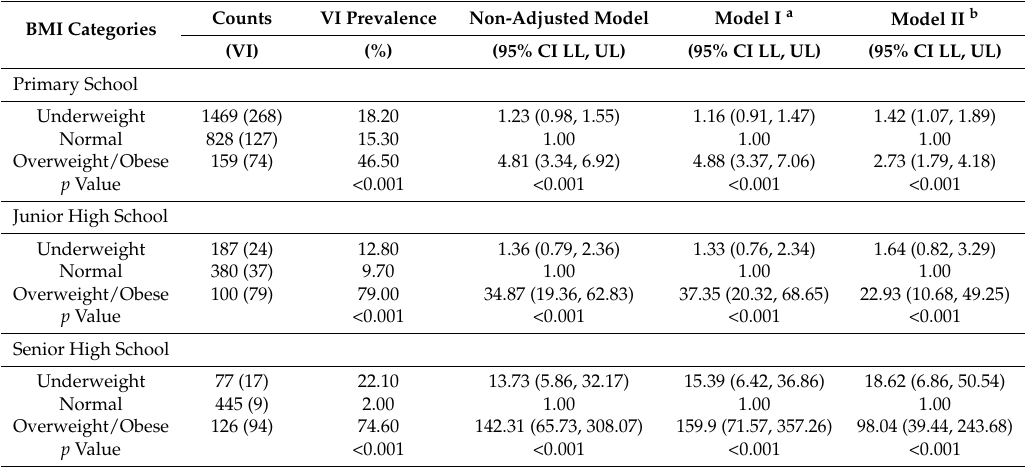
Table 3. The association between BMI and VI stratified by hierarchy.